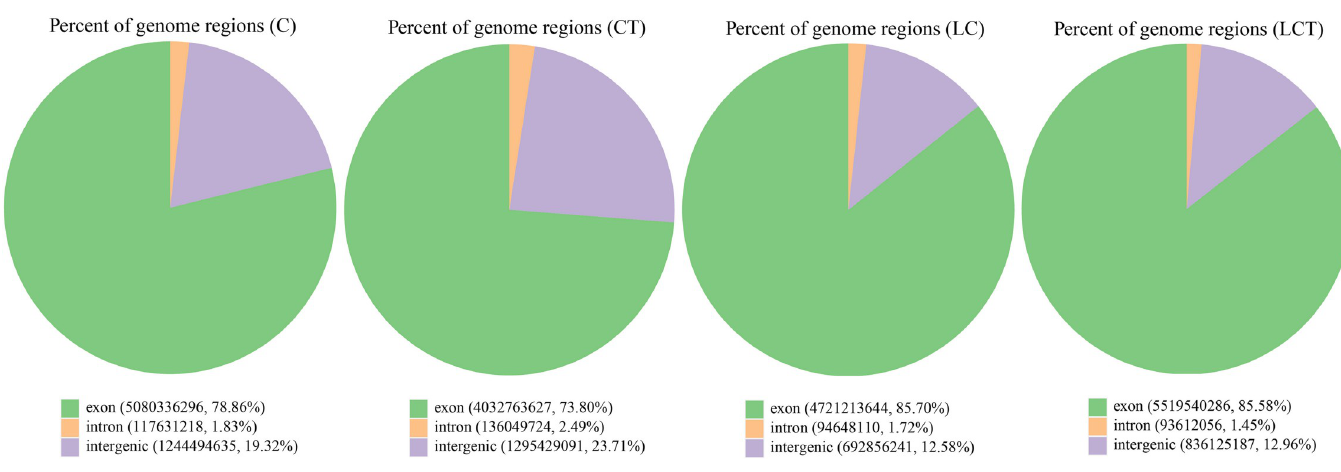
Fig 2. Distribution of reads in different regions of the reference